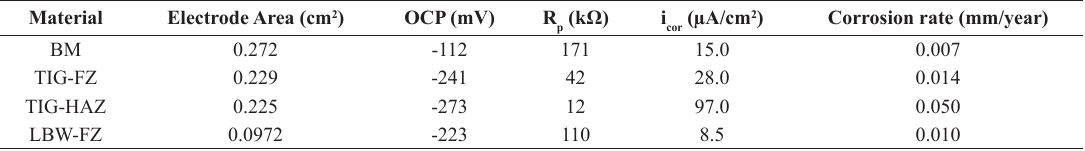
Table 3. Electrochemical parameters for each sample.